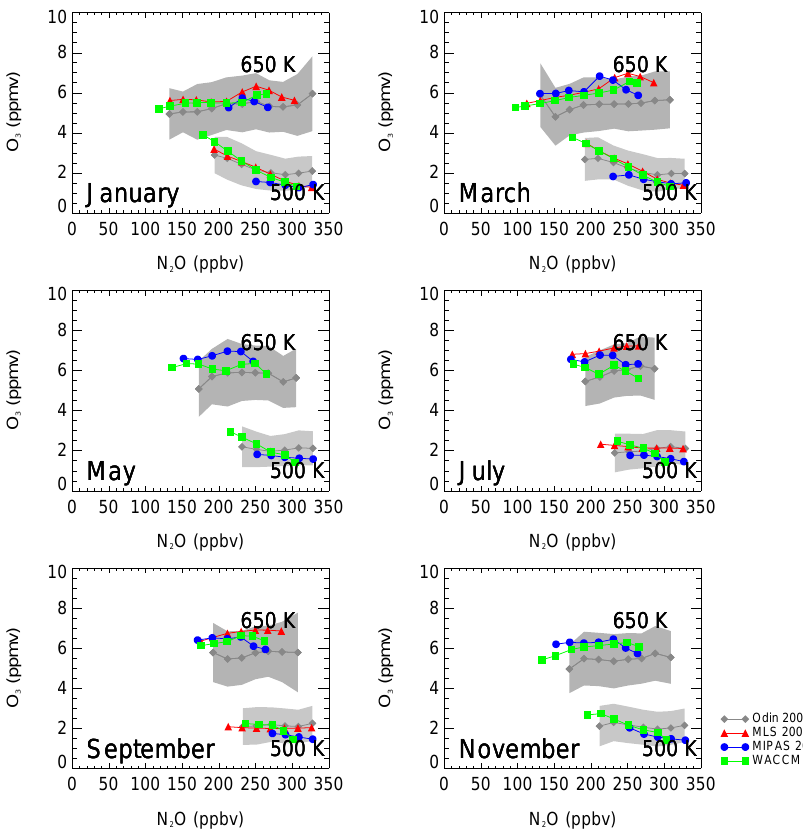
Fig. 12. Same as Fig. 11, but for 2006 and including Aura/MLS data and SD-WACCM data. Odin (grey diamonds), MLS (red triangles), MIPAS (blue circles) and SD-WACCM (green squares). Note: no MLS data available for May and November 2006. averaged values as high as the ones from Odin/SMR are found between February and April (Fig. 11 as well as Fig.